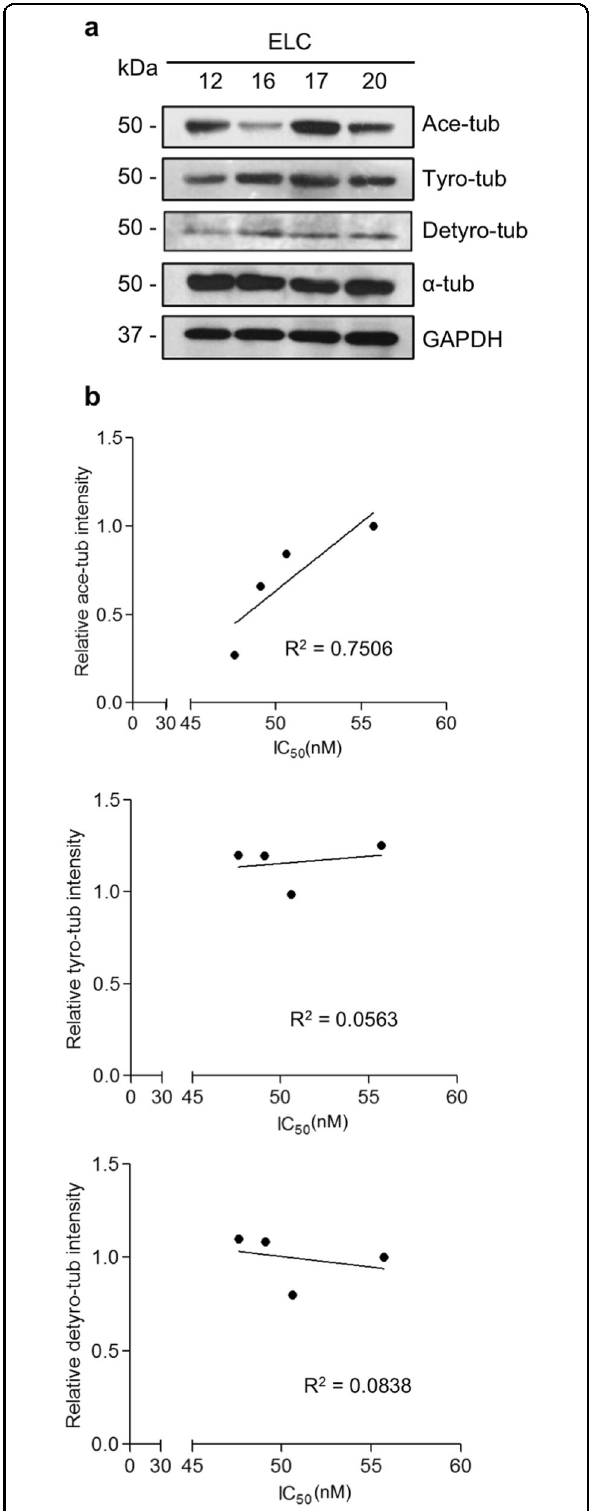
Fig. 1 Paclitaxel responsiveness and microtubule posttranslational modi fi cation (PTM) in patient-derived primary lung cancer cells. a Western blot analysis of acetylated tubulin (Ace- tub), tyrosinated tubulin (Tyro-tub), detyrosinated tubulin (Detyro-tub), and alpha-tubulin ( α -tub) expressions in each cell type. Representative blots from three independent experiments are shown. b Cells were treated with paclitaxel (0 – 200 nM) for 48 h, and cell viability was analyzed by MTT assay, and the 50% inhibitory concentration (IC 50 ) was assessed ( n = 3). Plots represent a correlation analysis performed between the relative expression levels of Ace-tub, Tyro-tub, or Detyro- tub and the IC 50 of paclitaxel in each cell